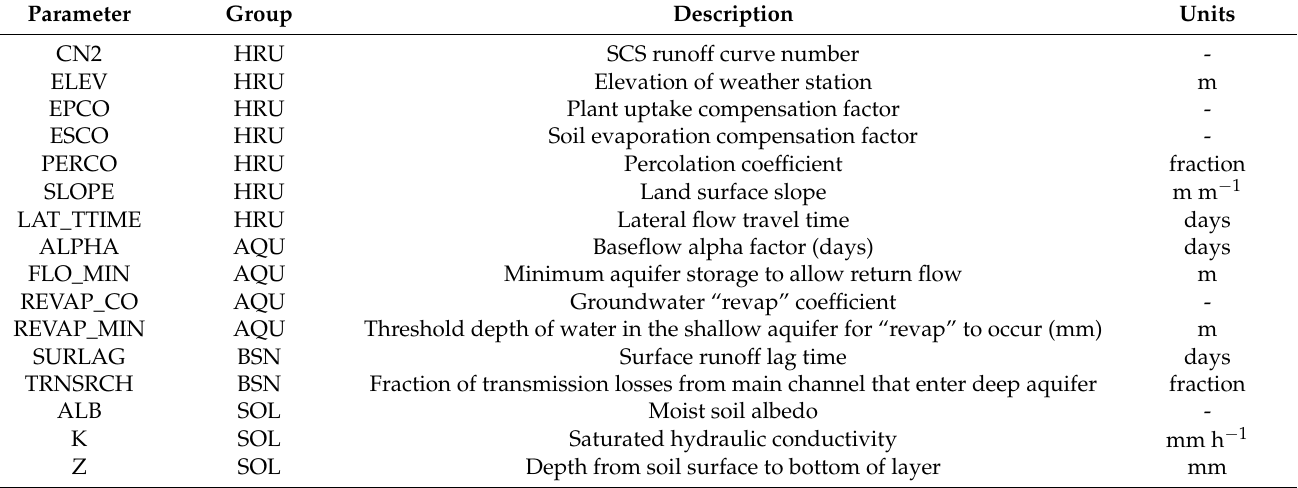
Table 4. Parameters used for the sensitivity analysis of the